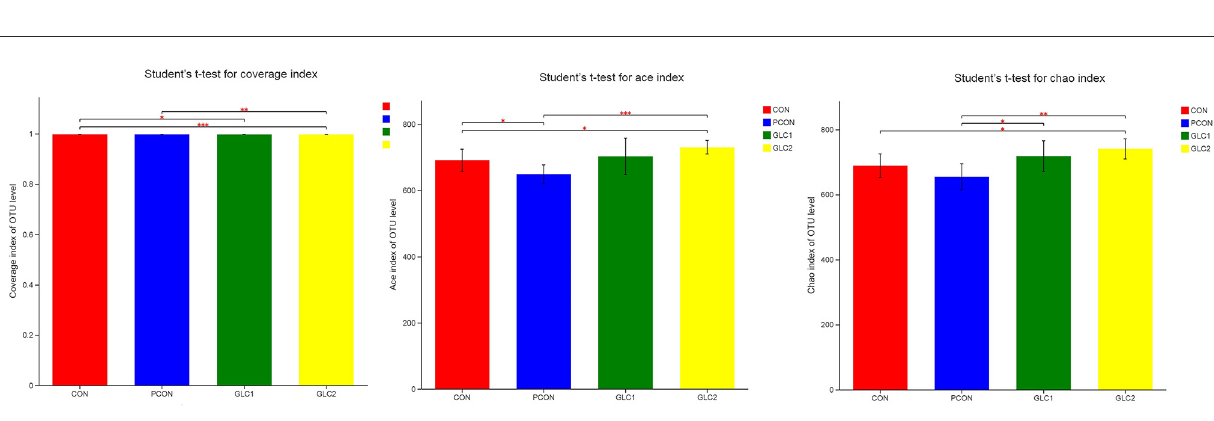
FIGURE4 Effect of Ganoderma lingzhi culture (GLC) supplementation on alpha diversity of the caecal microbiota ( n = 6; CON, control diet; PCON, positive control diet; GLC 1: 1.5% GCL diet; GLC 2: 3% GCL diet). * p < 0.05, ** p < 0.01, *** p <